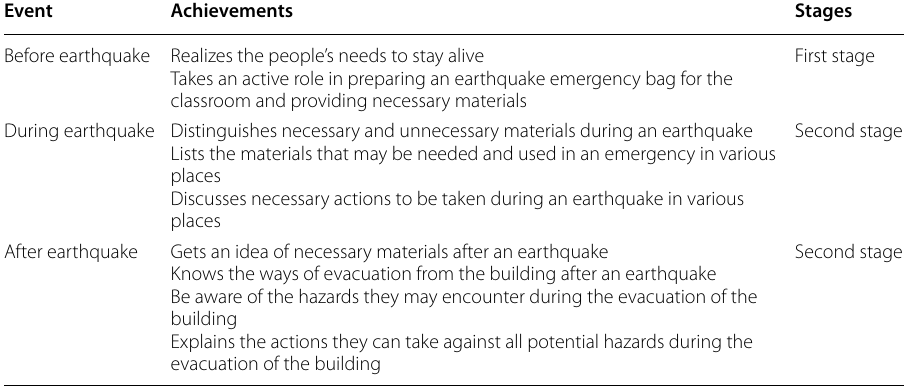
Table 3 Information on the game stage with the achievements Event Achievements Stages